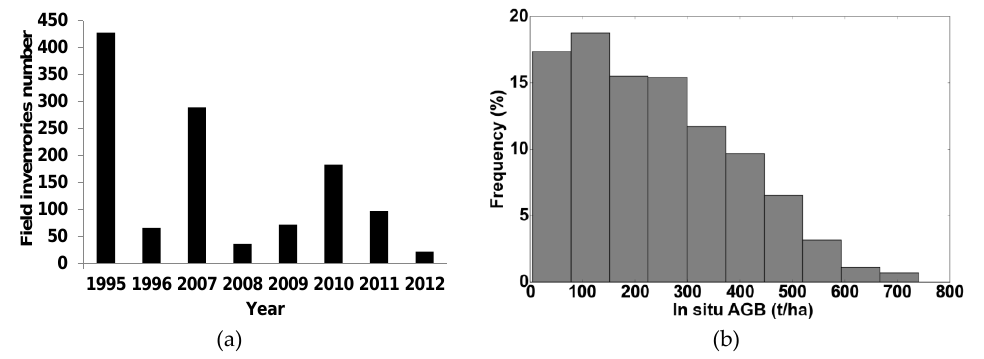
Figure 2. ( a ) Number of field inventories for a given year; ( b ) distribution of AGB density from field inventories.